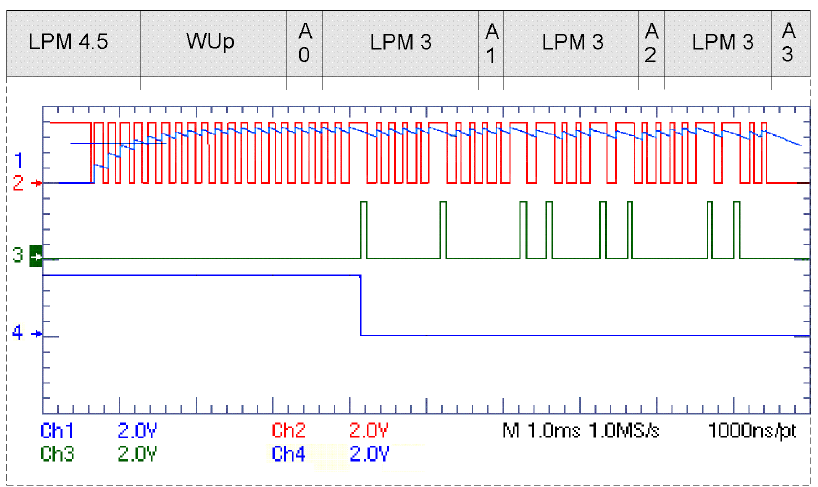
Table 3. MSP430 Power Modes from Figure 7.